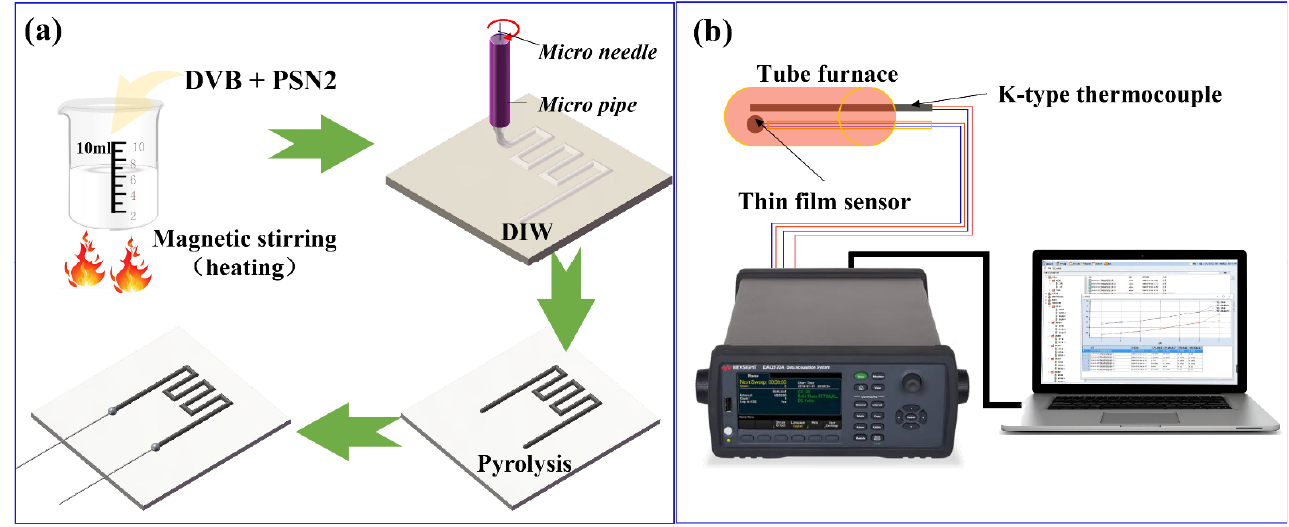
Figure 1. Schematic illustration of ( a ) process and ( b ) temperature-resistance test device.